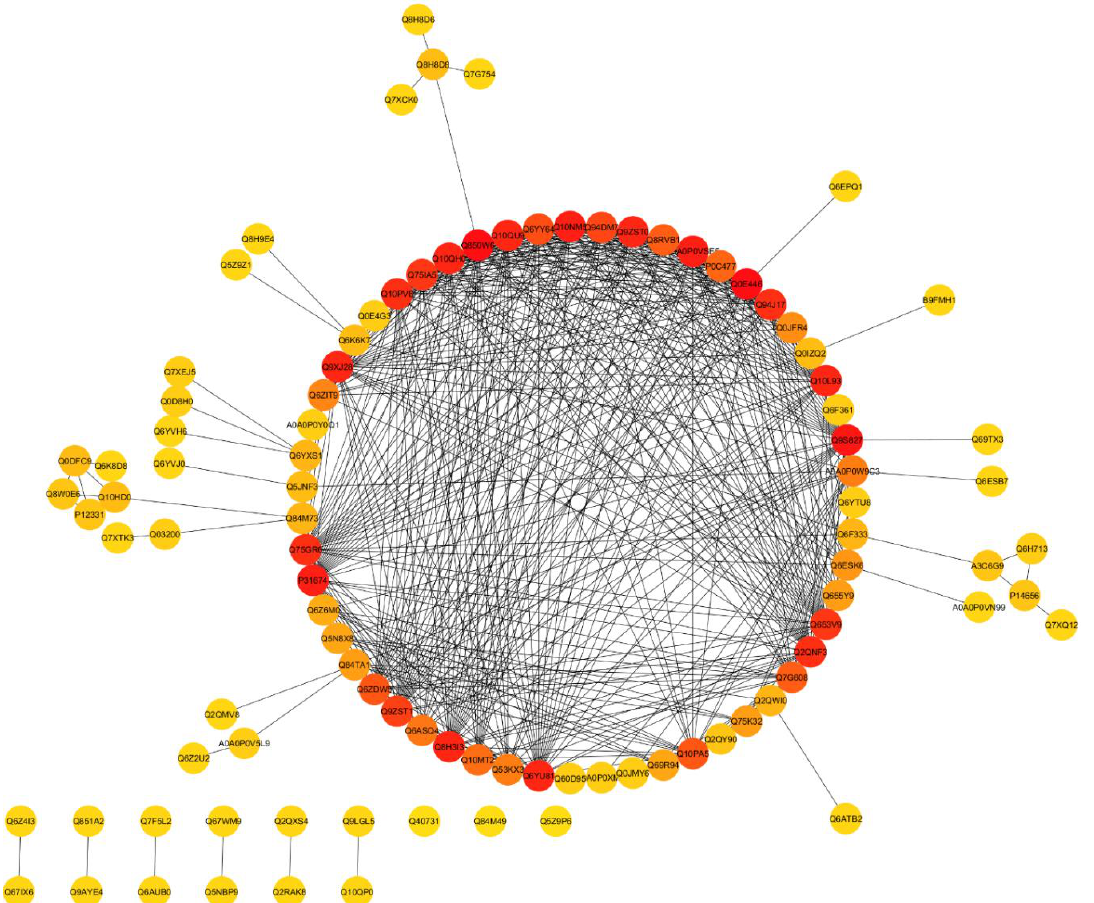
Figure 4. STRING predicted protein to protein interaction (PPI) of differentially expressed proteins (DEPs) between wild type and mutant lines (GN-5). Nodes with redder color show a higher co-expression level.